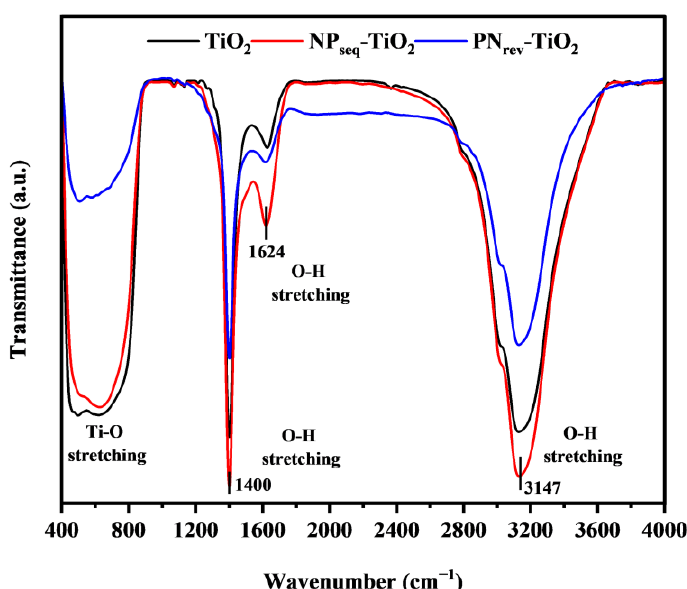
Figure 4. The FTIR spectrum for TiO 2 , NP seq -TiO 2 , and PN rev -TiO 2 photocatalysts.